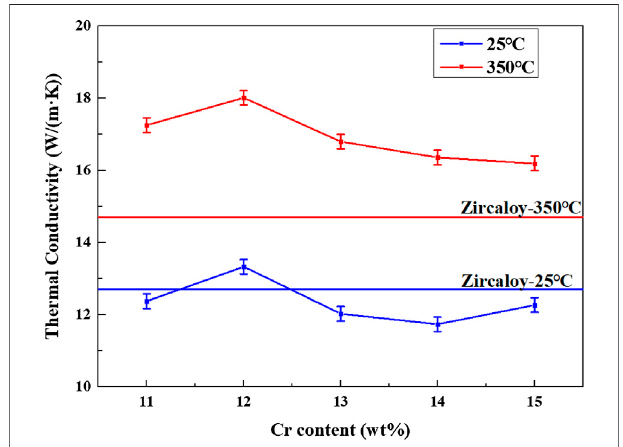
FIGURE 13 | The speci fi c heat of Fe – x Cr – 6Al alloy with different Cr content.